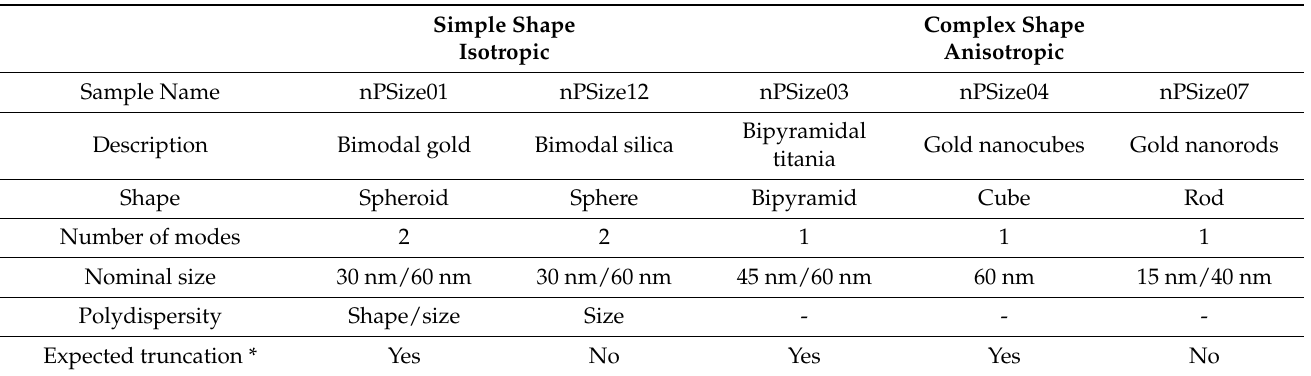
Table 1. Information on the materials investigated in this study including the chemical composition, shape, mode number, and